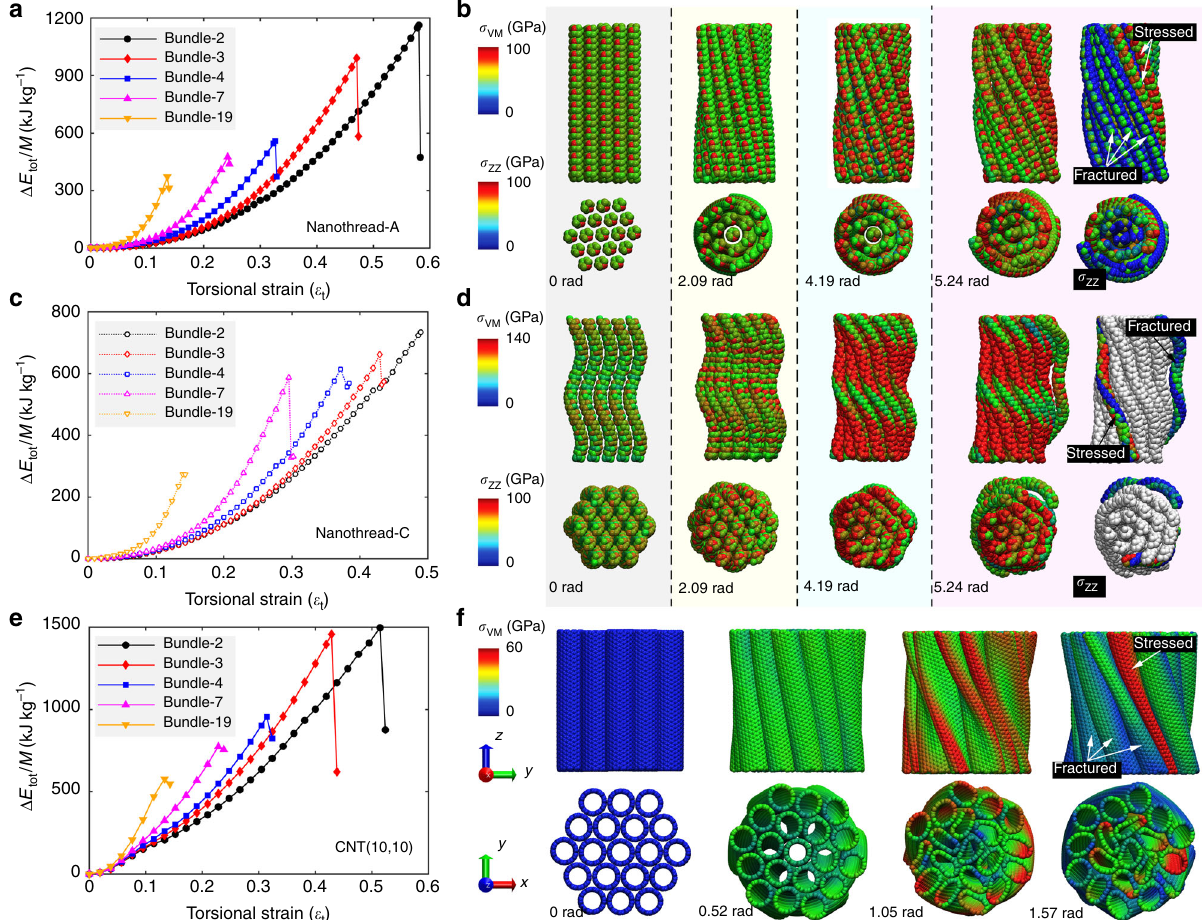
Fig. 4 Mechanical energy storage in bundle structures from simulation. a Strain energy density as a function of torsional strain of nanothread-A bundles and b the corresponding atomic con fi gurations of bundle-19. The last column is coloured based on axial atomic virial stress and the rest is coloured based on the atomic Von Mises (VM) stress; c strain energy density as a function of dimensionless torsional strain of nanothread-C bundles; and d the corresponding atomic con fi gurations of bundle-19. For clarity, in the last column only one fractured and one connected (stressed) fi laments are coloured based on axial atomic virial stress; e strain energy density as a function of the dimensionless torsional strain of CNT bundles; and f the corresponding atomic con fi gurations of bundle-19. For b , d , f , the atomic con fi gurations show only a middle segment (~6 nm) of the whole sample, and only C atoms are visualized for nanothread